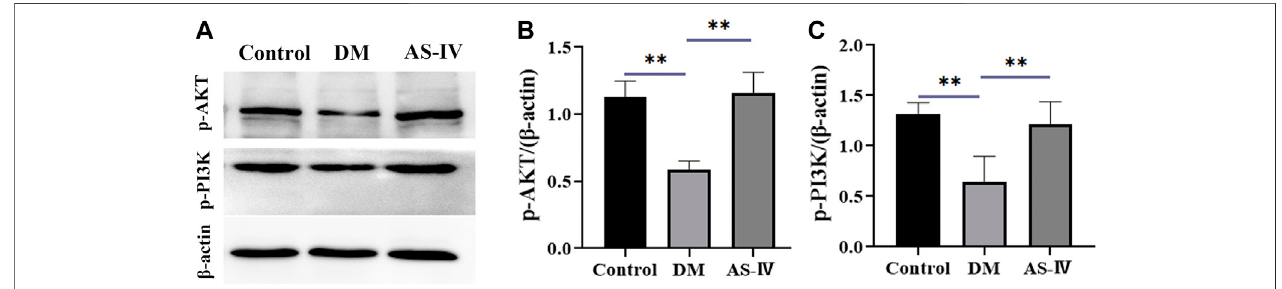
FIGURE 8 | The role of PI3K-AKT signaling in the therapeutic ef fi cacy of AS-IV in DR. (A) Protein bands of p-AKT, p-PI3K and β -actin in control, DM and AS-IV groups. Protein levels quanti fi cation of (B) p-AKT and (C) p-PI3K among control, DM and AS-IV groups. DM, diabetes mellitus; AS-IV, astragaloside IV. Data were presented as mean ± SD, ** p <